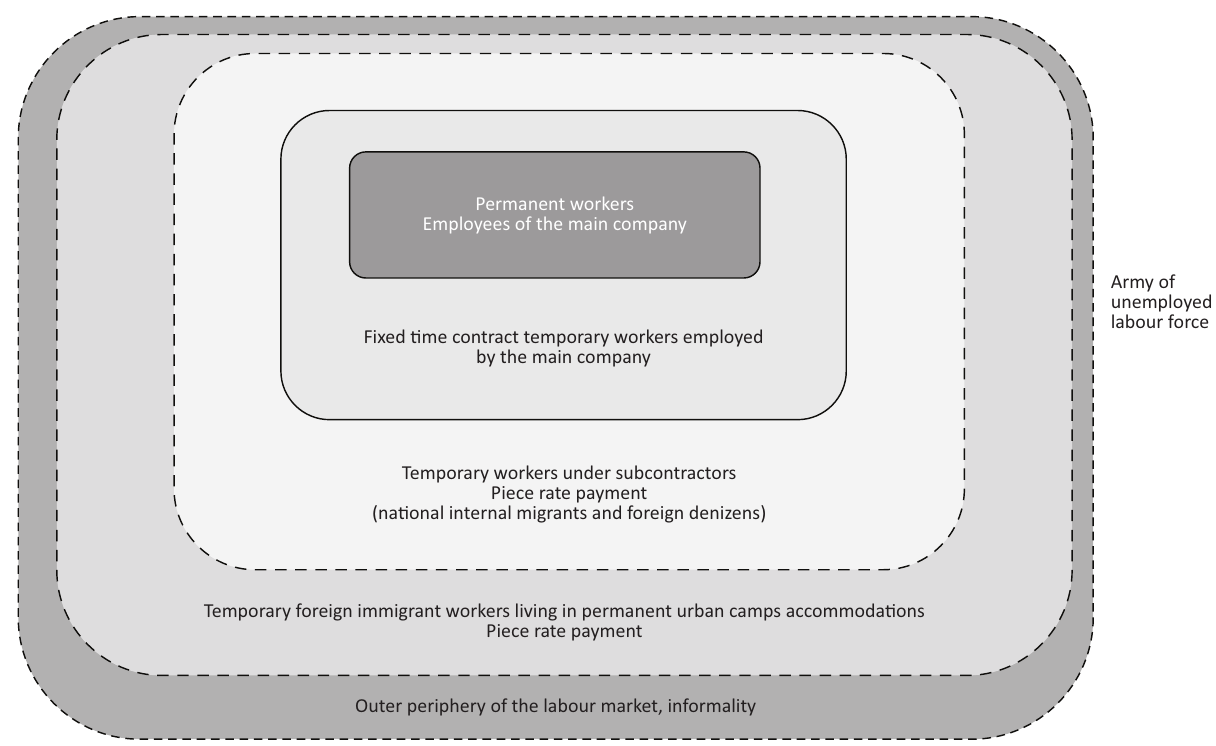
Figure 11. Multiplicity of labour positions in Chilean agribusiness. Source: Own